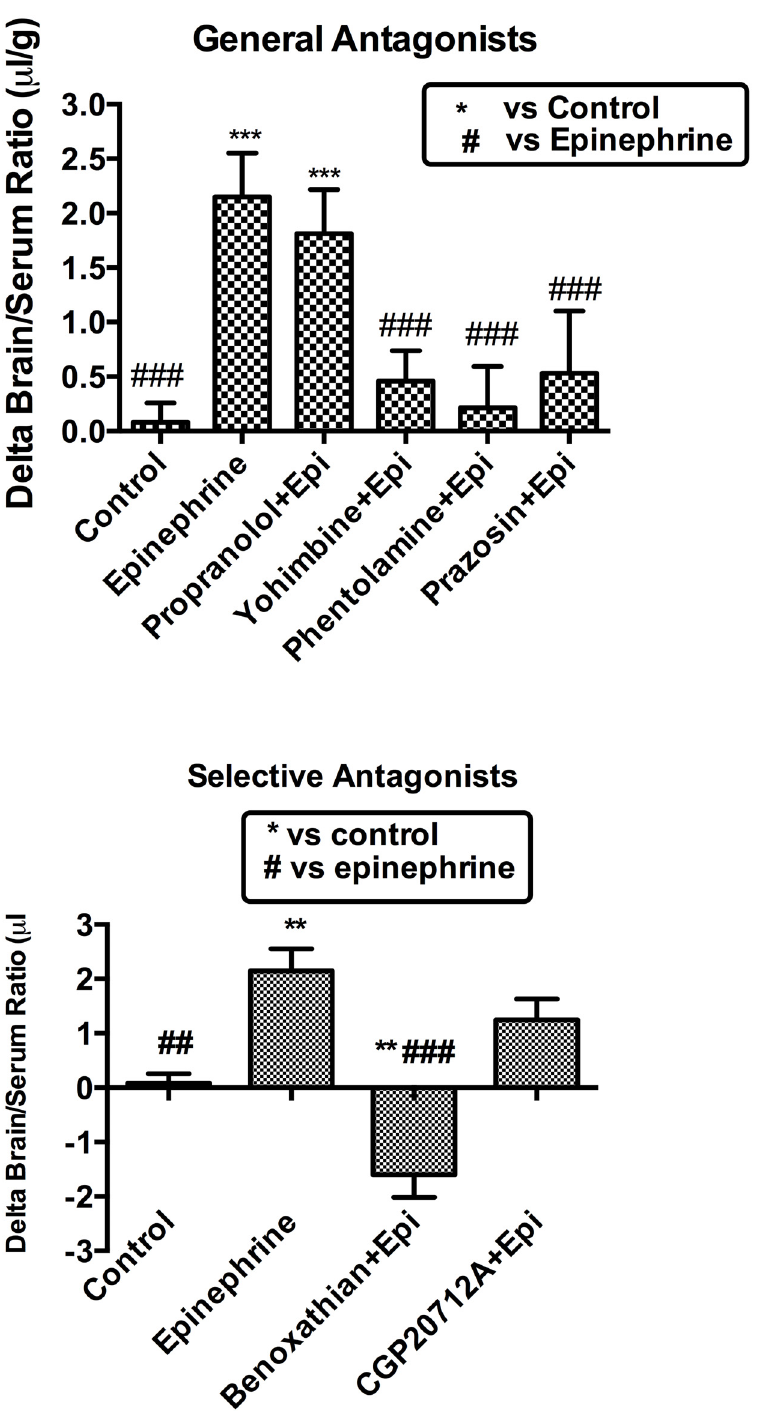
Fig 3. Effect of adrenergic antagonists on epinephrine-induced uptake of I-PGUS across the BBB. Upper panel shows that more general alpha, alpha1, and alpha2 antagonists but not beta antagonists blocked epinephrine ’ s effect. Lower panel shows results that the highly selective alpha1 adrenergic receptor antagonist benoxathian but not the highly selective beta adrenergic receptor antagonist CPG20712A blocked the effect of epinephrine. ** p < 0.01 and *** p < 0.001 inc comparison to control; ##p < 0.01 and ###p < 0.001 in comparison to epinephrine.